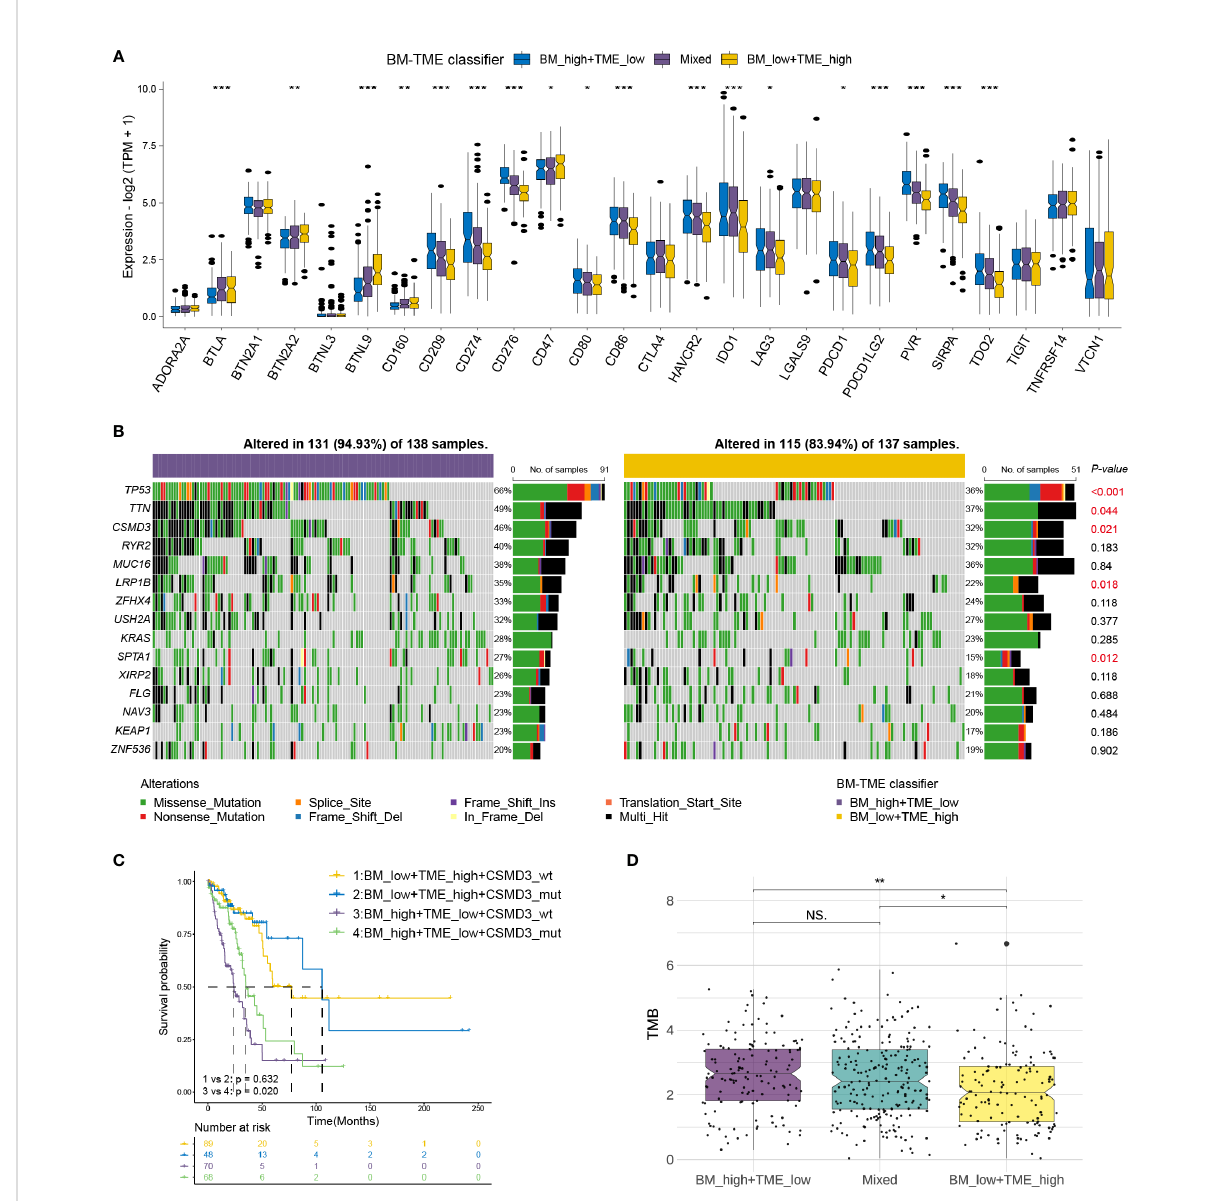
FIGURE 6 Correlations of immune checkpoints and somatic mutation with BM-TME classi fi er in TCGA-LUAD cohort. (A) The differential expression levels of immune checkpoint genes among BM-TME classi fi er subgroups. (B) Waterfall plots depicting the mutation landscape of the top 15 genes with high mutation frequency. P -values on the right side displaying the signi fi cance of differences in 15 gene mutation frequencies between two BM-TME groups. (C) Kaplan – Meier curves of patients with LUAD divided by the CSMD3 mutation status and BM-TME classi fi er. (D) The distribution of TMB among different BM-TME classi fi er subgroups. *p<=0.05, **p<=0.01 and ***p<=0.001, respectively. ns, no signi fi